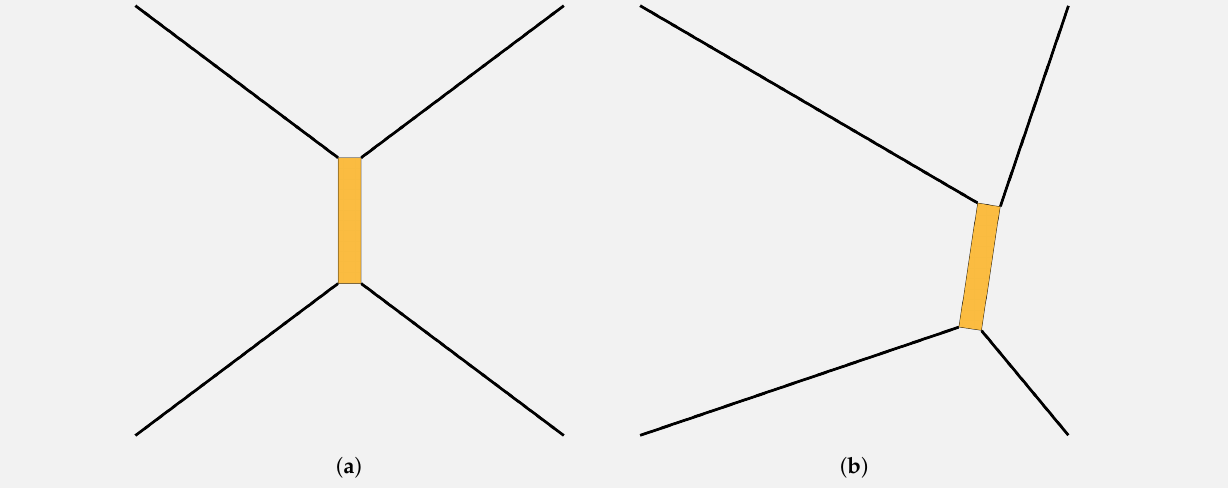
Figure 9. The platform configurations of Table 2. ( a ) Platform configuration 1 ( b ) Platform configuration 2.